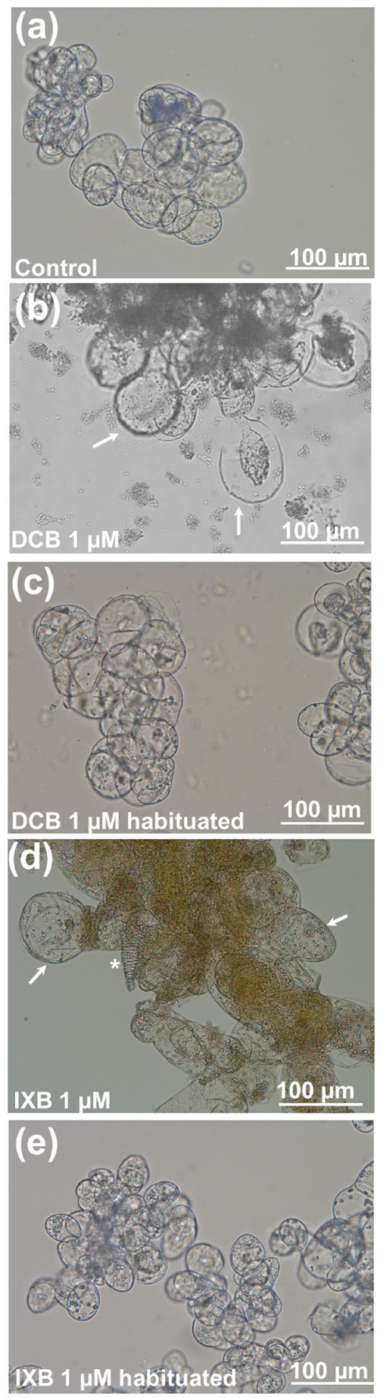
Figure 3. Optical microscope pictures of control C. plantagineum cells ( a ), either non-habituated ( b , c ) or habituated ( d , e ) to DCB and IXB 1 µ M. The white arrows indicate bulges and swollen regions in the cells. A tracheary element is visible in panel h